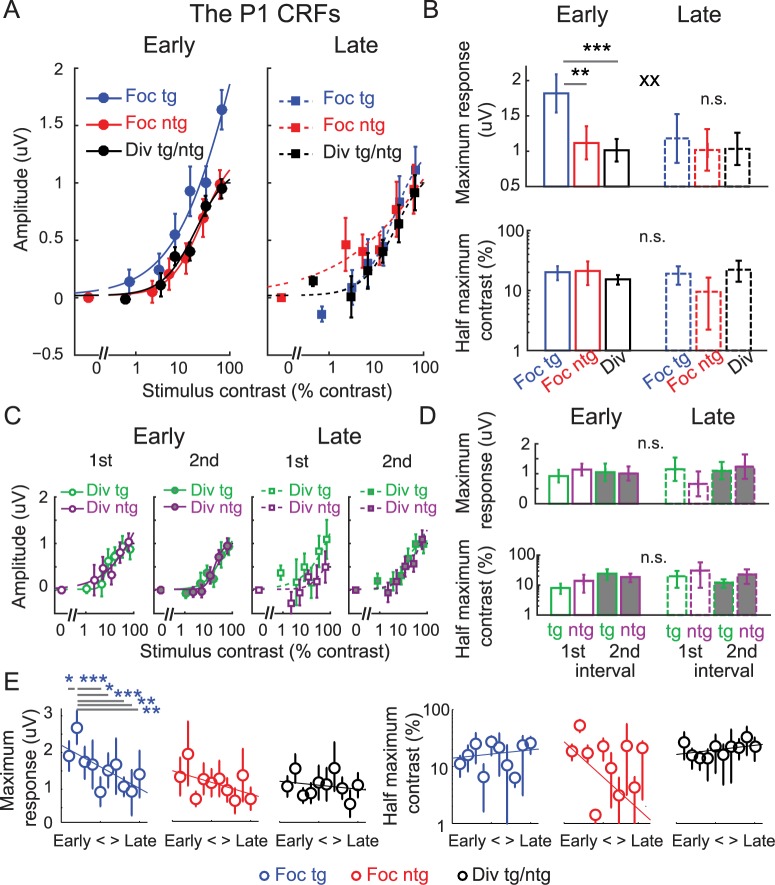
Modulations of the P1 component with baseline subtraction.The contrast response functions (CRFs), based on the amplitude of the extracted P1 component, which was averaged over the contralateral posterior–occipital electrodes from 80–130 ms poststimulus. During the early training phase, there was a robust attentional gain amplification of the P1 component on focused attention trials compared to divided attention trials (left panel). However, no attention-related gain modulations were present during the late training phase (right panel). Error bars represent within-subject SEM. (B) Corresponding maximum response (response at 100% contrast minus baseline) and half-maximum contrast for the P1-based CRFs in (A). Error bars represent the 68% CIs; ** and *** represent significant pairwise comparisons between attention conditions in each training phase with p < 0.01 and p < 0.001, respectively. Note that in this and subsequent figures, we use 68% CIs for data that were analyzed via nonparametric bootstrapping methods (e.g., the fit parameters) and within-subject SEM for data that were analyzed using standard parametric approaches. xx represents a significant interaction between training (early and late) and attention (focused target and divided attention), with p < 0.01. (C) The P1-based CRFs evoked by the divided target and divided nontarget stimuli during the first and second stimulus intervals across the early and late training phases. There was no significant change in the P1-based CRFs across these stimulus conditions and training phases. This justified averaging between the P1 data elicited by the divided target and divided nontarget stimuli from both stimulus intervals. Error bars represent within-subject SEM. (D) Corresponding maximum response and half-maximum contrast for the P1-based CRFs in (C). Error bars represent the 68% CIs. (E) The day-by-day analysis of the P1 data with baseline subtraction (2 electroencephalography [EEG] sessions or ~1 day per each time bin). Left and right panels represent the estimated maximum response and half-maximum contrast parameters. Error bars represent the 68% CIs. Blue *, **, and *** in (E) represent significant pairwise comparisons between the maximum response on the second time bin in which the behavioral performance started to reach a saturation level (Fig 2C) and the maximum response in other time bins with p < 0.05, p < 0.01, and p < 0.001 (false discovery rate [FDR]-corrected). Note that the contrast values on the x-axis in (A) and (C) are not exactly the same across target and nontarget conditions because in the target conditions, we used the averaged contrast values of the pedestal and incremental stimuli. Data are available from the Open Science Framework (https://osf.io/pc7dr/). n.s., not significant.